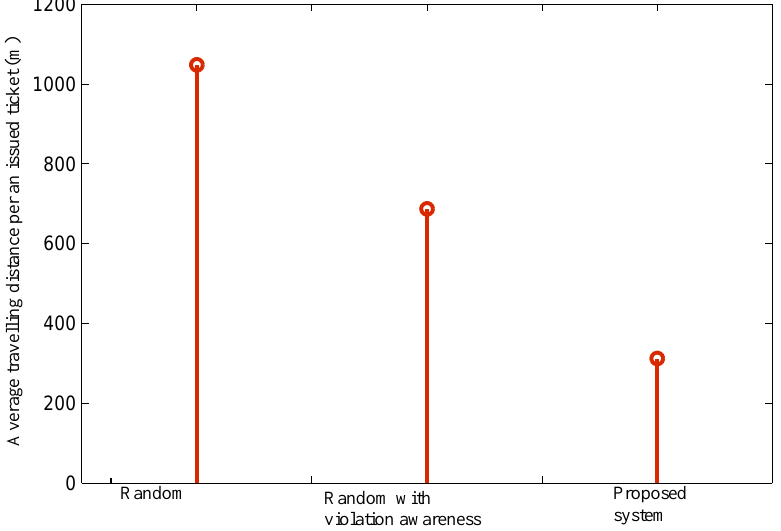
Figure 16. Average travelling distance of officers per an issued ticket in regions with low violation